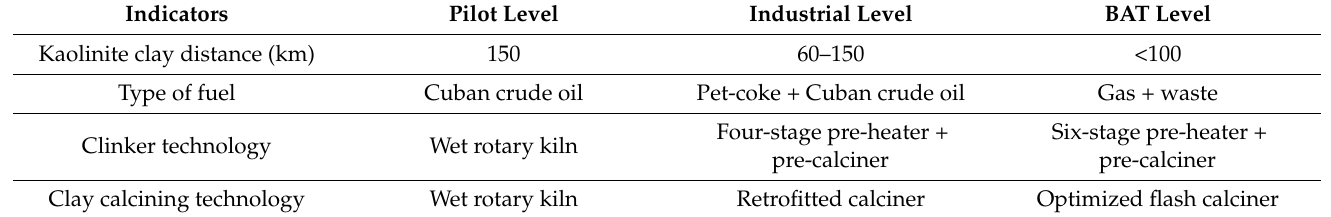
Figure 1. CO 2 emissions of LC3 in comparison with other cement. Reprinted with permission from Ref. [3]. Copyright: 2018, Karen Scrivener. Published by Elsevier.